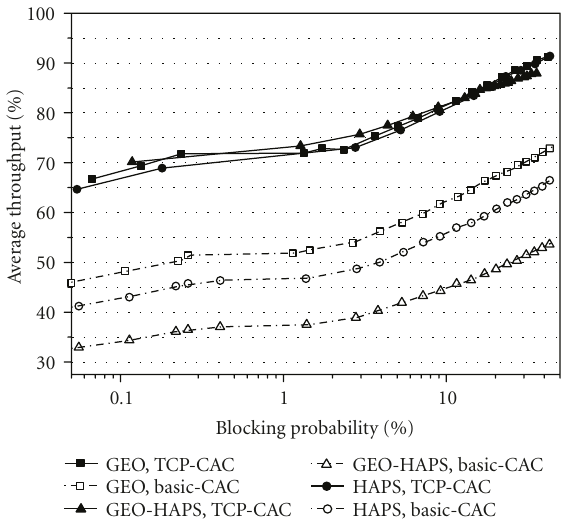
Figure 7: Blocking probability decrease versus average tra ffi c load. Figure 8: Average throughput versus blocking